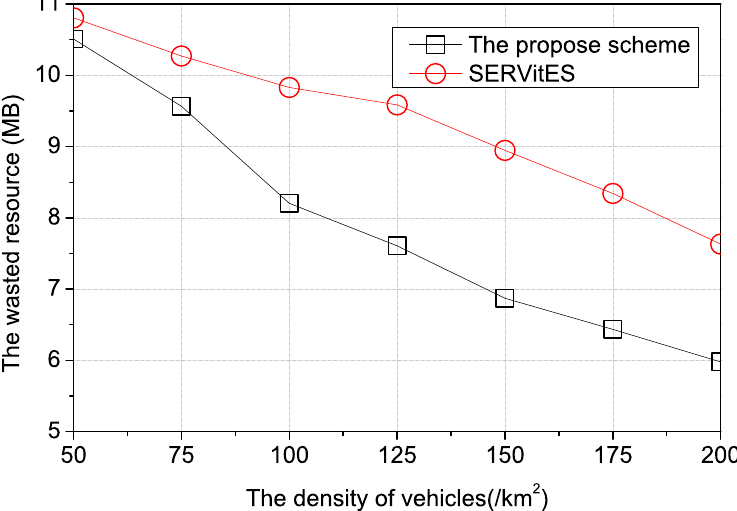
Figure 5. The wasted resources according to the density of